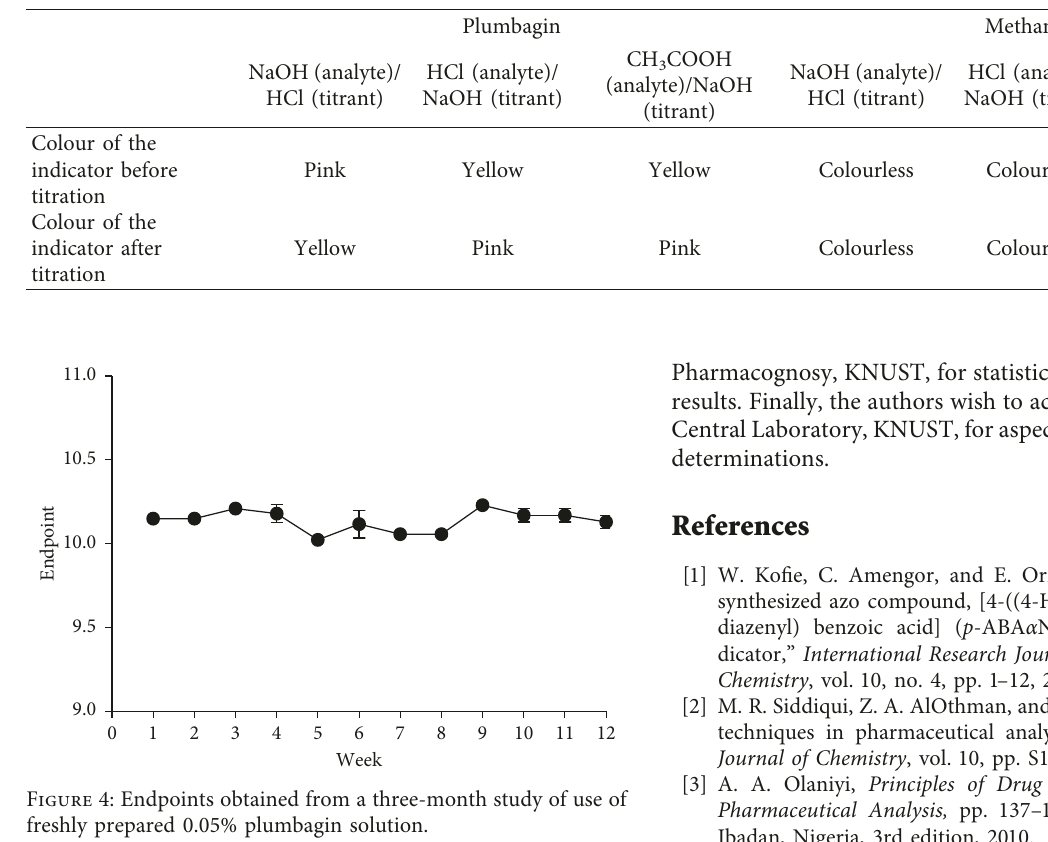
Table 9: Colour of the indicator and solvent in different solutions on evaluation of specificity.